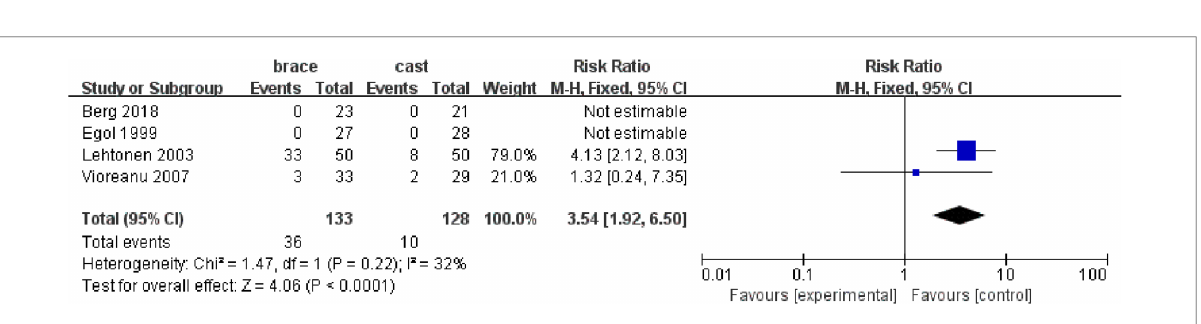
FIGURE 5 Forest plot of the comparison of cast versus brace groups for the wound complication. CI, con fi dence interval; M-H, Mantel-Haenszel test.